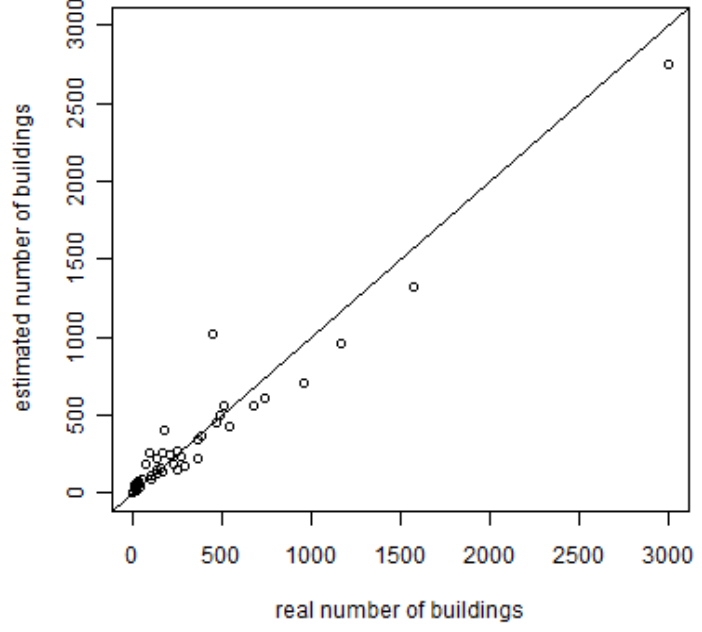
Figure 8. Comparison of the estimated number of buildings from the built-up mask with the real number of buildings in 49 test-areas from manual digitization. Test-areas have been selected following a stratified sampling approach using the urban structure types as